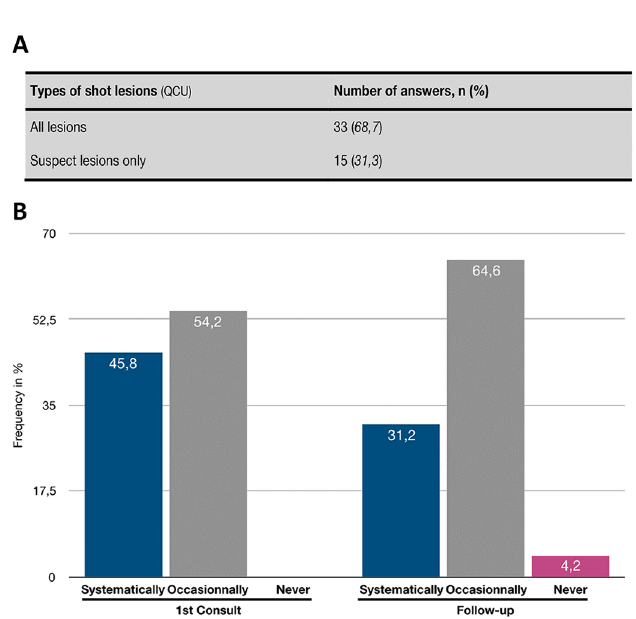
Fig. 2. Use of photography. (A) Type of shot lesions. (B) Frequency of photography ’ s